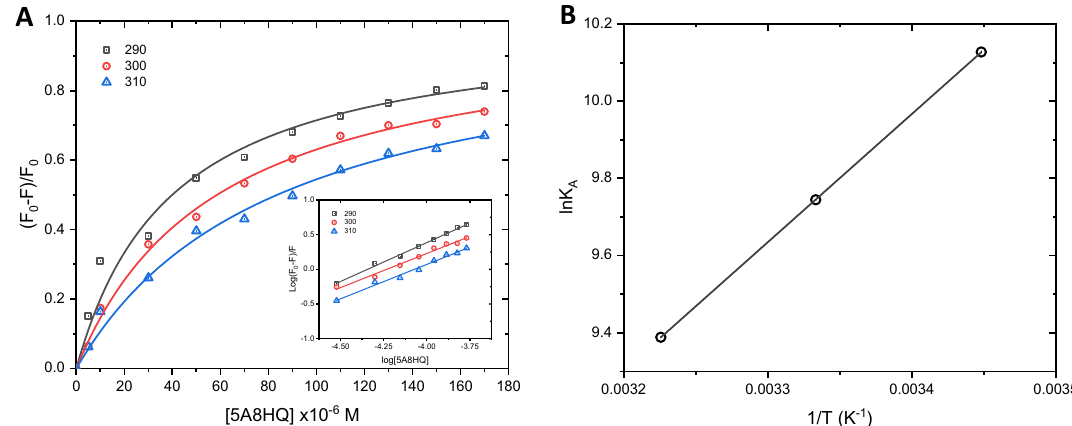
Figure 4. ( A ) Nonlinear Hill’s equation fitted on fluorescence dataset of BSA (4 µM) in the presence of 5A8HQ (0–170 µM) at 290, 300, and 310 K. Inset is a linearized Hill’s plot. ( B ) Van’t Hoff plot of lnK A versus 1 / T for the binding of 5A8HQ with BSA.